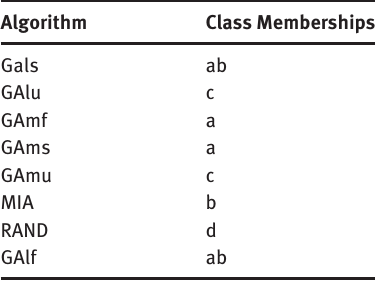
Table 6. Length 58 2 PSK: Tukey HSD Class